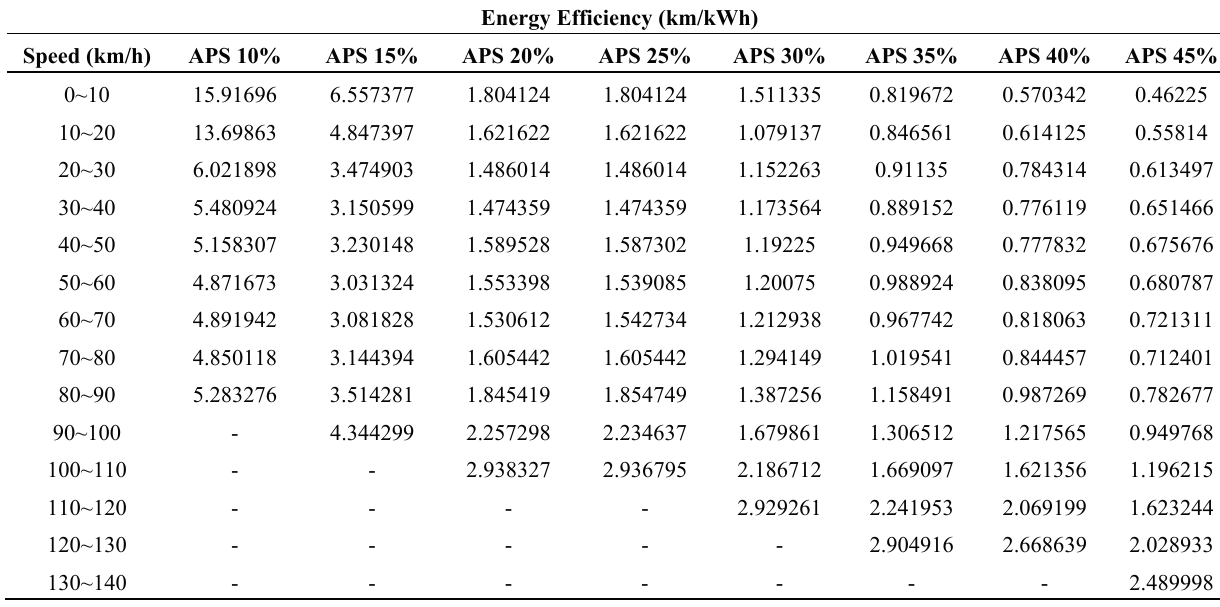
Table 1. Energy efficiency according to vehicle speed and accelerator pedal stroke